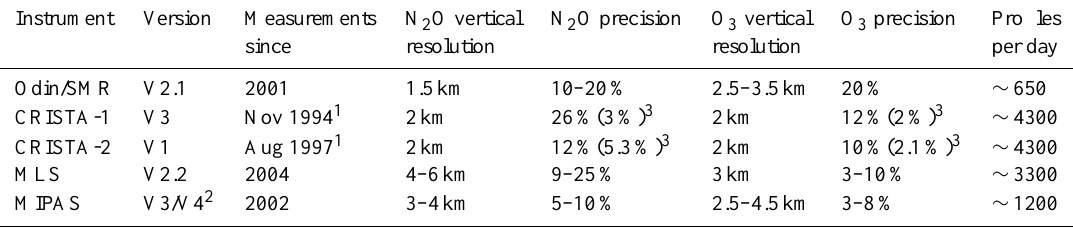
Table 1. Satellite measurements used in this study. Instrument Version Measurements N 2 O vertical N 2 O precision O 3 vertical O 3 precision Profiles since resolution resolution per day Odin/SMR V2.1 2001 1.5km 10–20% 2.5–3.5km 20% ∼ 650 CRISTA-1 V3 Nov 1994 1 2km 26%(3%) 3 2km ∼ 4300 CRISTA-2 V1 Aug 1997 1 2km 12%(5.3%) 3 2km MLS V2.2 2004 4–6km 9–25% 3km 3–10% ∼ 3300 MIPAS V3/V4 2 2002